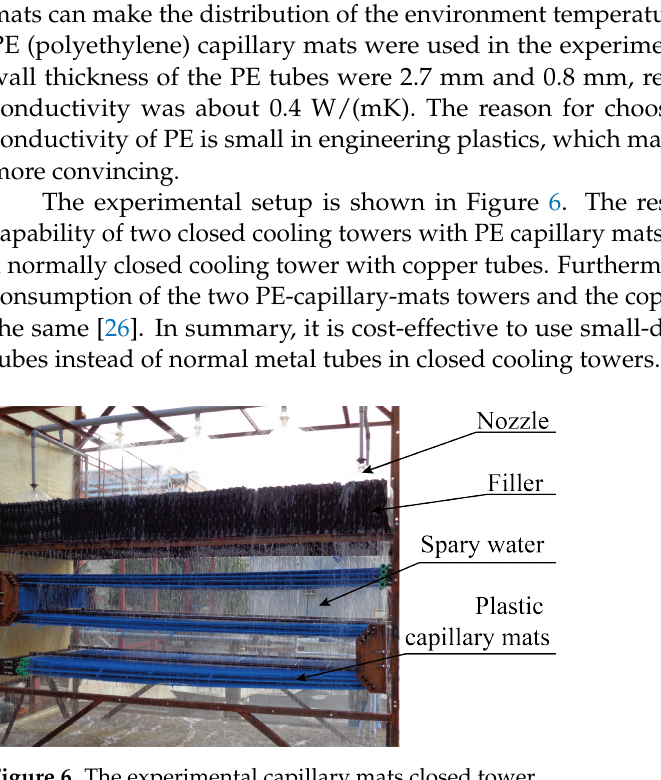
Figure 6. The experimental capillary mats closed